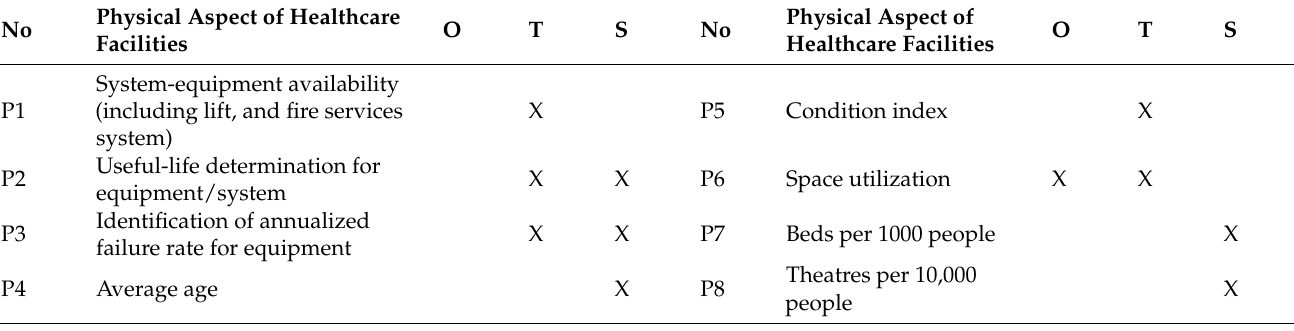
Table 5. FM KPIs for physical aspect of healthcare facilities (O: operational, T: tactical, S: